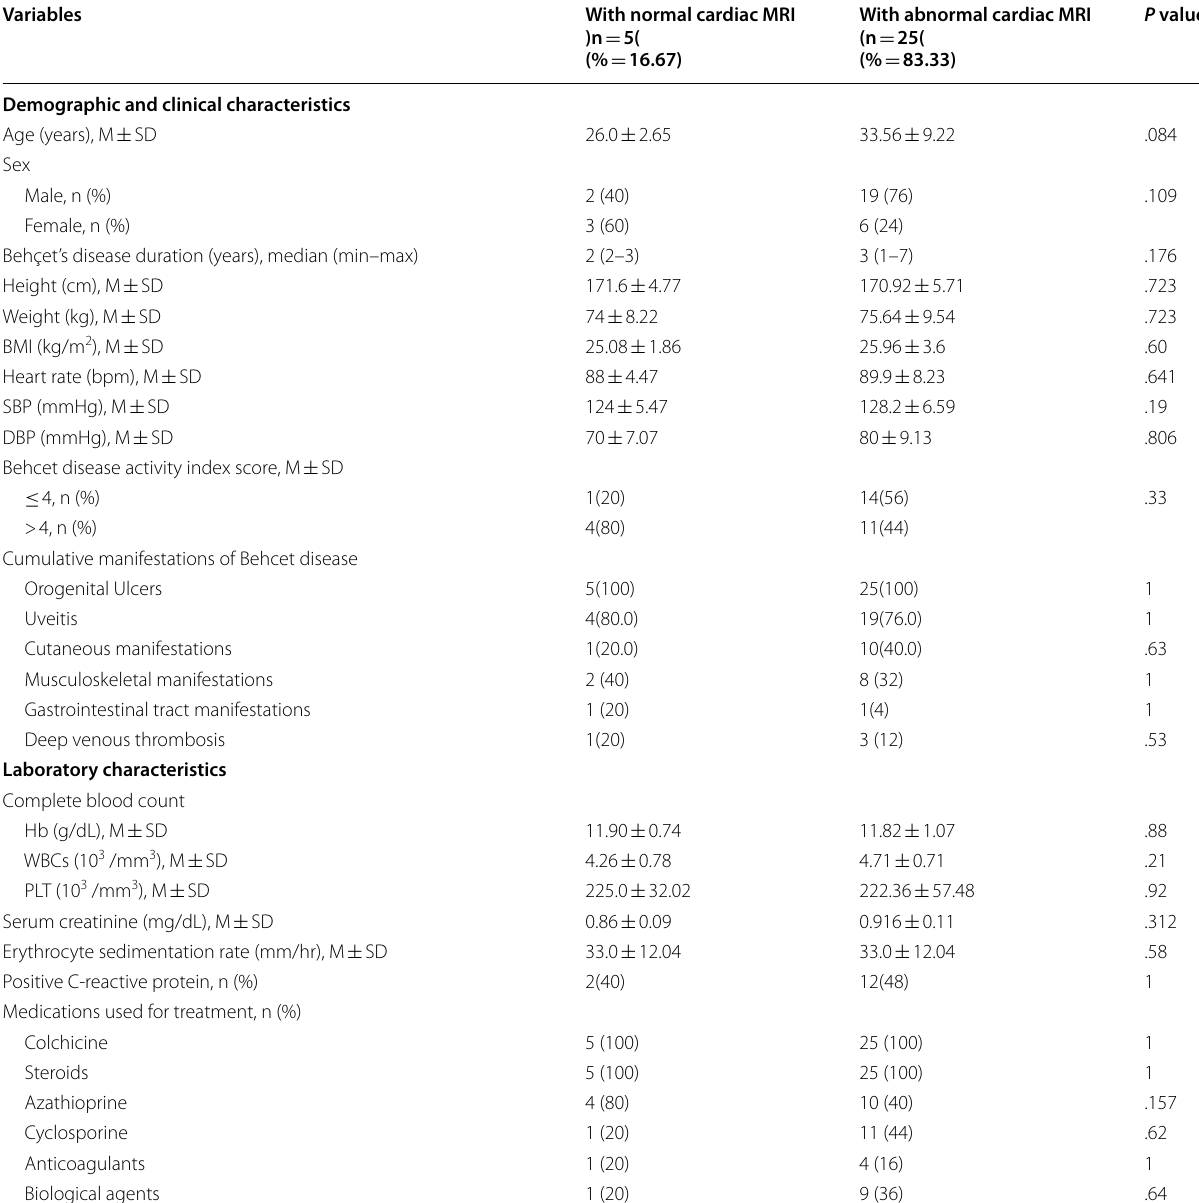
Table 3 Comparison between the studied patients with normal and abnormal cardiac MRI